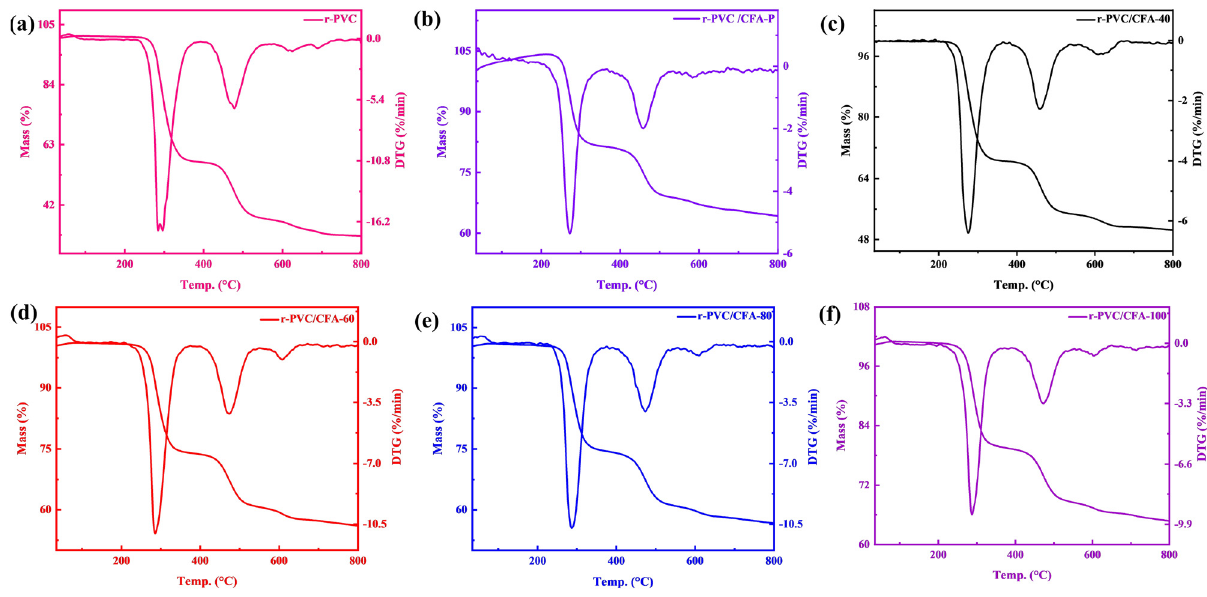
Figure 7: TGA and DTG curves for ( a ) r - PVC, ( b ) r - PVC/CFA - P composites ( 80 phr CFA ) , and ( c – f ) r - PVC/CFA - X composites varied with X ( 40, 60, 80, and 100 ) .